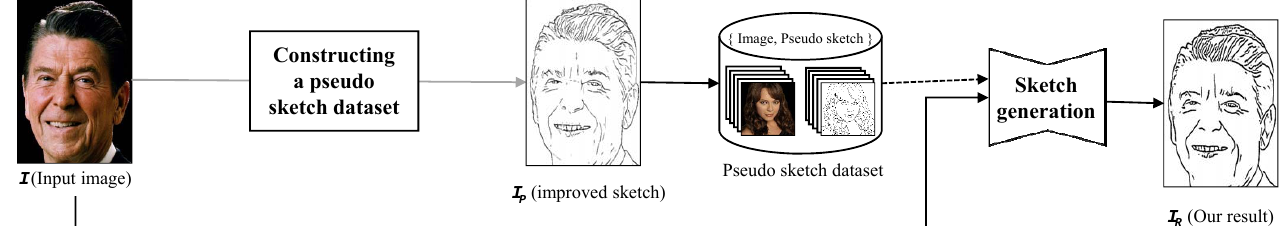
Figure 2. The overview of the proposed framework. From a series of input images, a pseudo-sketch dataset, which is further employed for training a sketch generation module, is constructed. Finally, the proposed framework produces a line-based sketch that preserves important lines and reduces unwanted artifacts.